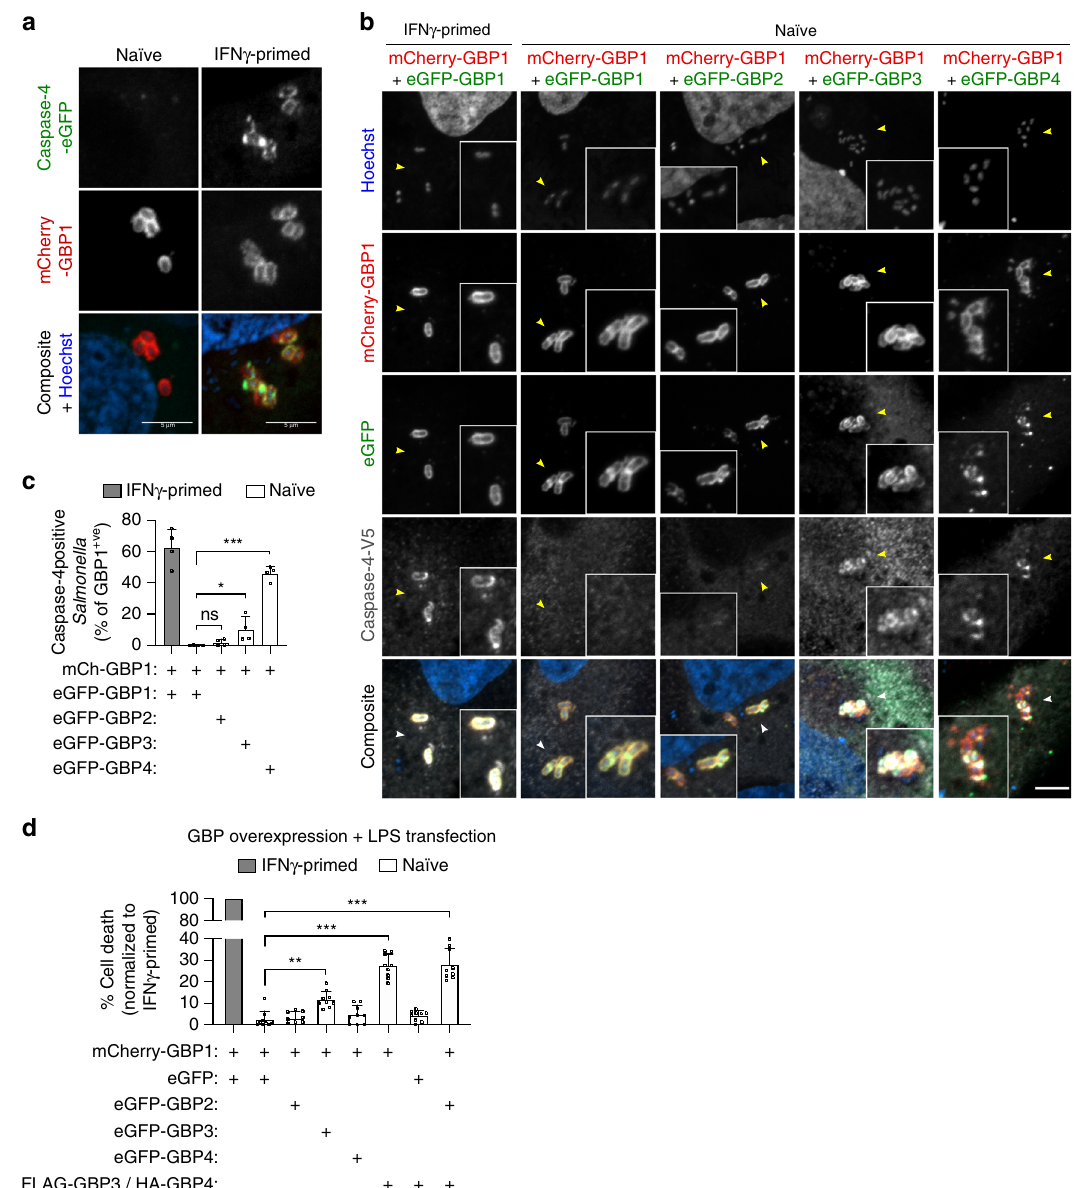
Fig. 5 GBP1/4 are suf fi cient to recruit caspase-4 to Salmonella and together with GBP3 activate the non-canonical in fl ammasome in naive human epithelial cells. a Fluorescence confocal microscopy of naive and IFN γ -primed HeLa co-expressing caspase-4-eGFP (green) and mCherry-GBP1 (red) and infected with Salmonella for 1 h. DNA was stained with Hoechst (blue). Representative confocal images are shown and scale bar corresponds to 5 µ m. b Fluorescence confocal microscopy of IFN γ -primed or naive HeLa cells co-expressing mCherry-GBP1 (red), Dox-inducible eGFP-GBP1, − 2, − 3 or − 4 (green) and caspase-4-V5 (gray), and infected with Salmonella for 1 h. DNA was stained with Hoechst (blue). eGFP-GBPs were expressed by inducing cells with 1 µ g/mL Dox for 16 h. Caspase-4-V5 was visualized by immunostaining with an anti-V5 antibody. Representative confocal images are shown and scale bar corresponds to 10 µ m. c Percentage of caspase-4-V5 positive Salmonella at 1 h p.i., quanti fi ed out of the mCherry-GBP1-positive bacteria. At least 50 GBP1-positive bacteria were counted per coverslip. d Percentage of cell death in HeLa cells co-expressing constitutive mCherry-GBP1 and Dox-inducible eGFP or eGFP-GBP1, − 2, − 3 or − 4. FLAG-GBP3 and HA-GBP4 were constitutively expressed together using a bicistronic plasmid. Cells were transfected with the indicated plasmids for 24 h. eGFP-GBPs were induced for 16 h with 1 µ g/mL Dox, whereas eGFP was induced for 3 h. Cells were then transfected with E. coli -derived LPS (2.5 µ g/50,000 cells) for 6 h and cell death values were normalized considering IFN γ -primed HeLa as 100% and naive cells co- expressing mCherry-GBP1 and eGFP as 0%. Graphs show the mean ± SD, and data are pooled from two independent experiments performed in duplicate ( c ), pooled from three independent experiments performed in triplicate ( d ) or are representative from two ( b ) or three ( a ) independent experiments. ** P < 0.01; *** P < 0.001; one-way (Fig. 7a, b and Supplementary Fig. 13), indicating that the non-canonical in fl ammasome pathway. Basic residues in the N- phosphate groups found on Lipid A and inner core sugars of LPS terminal domain of LBP mediate binding to LPS micelles 39 . We thus mutated several positively charged surface patches in GBP1 (Supplementary Fig. 12b) play an essential role in promoting and tested the impact of the mutations on GBP1-LPS interaction GBP1-LPS interaction and subsequent activation of the